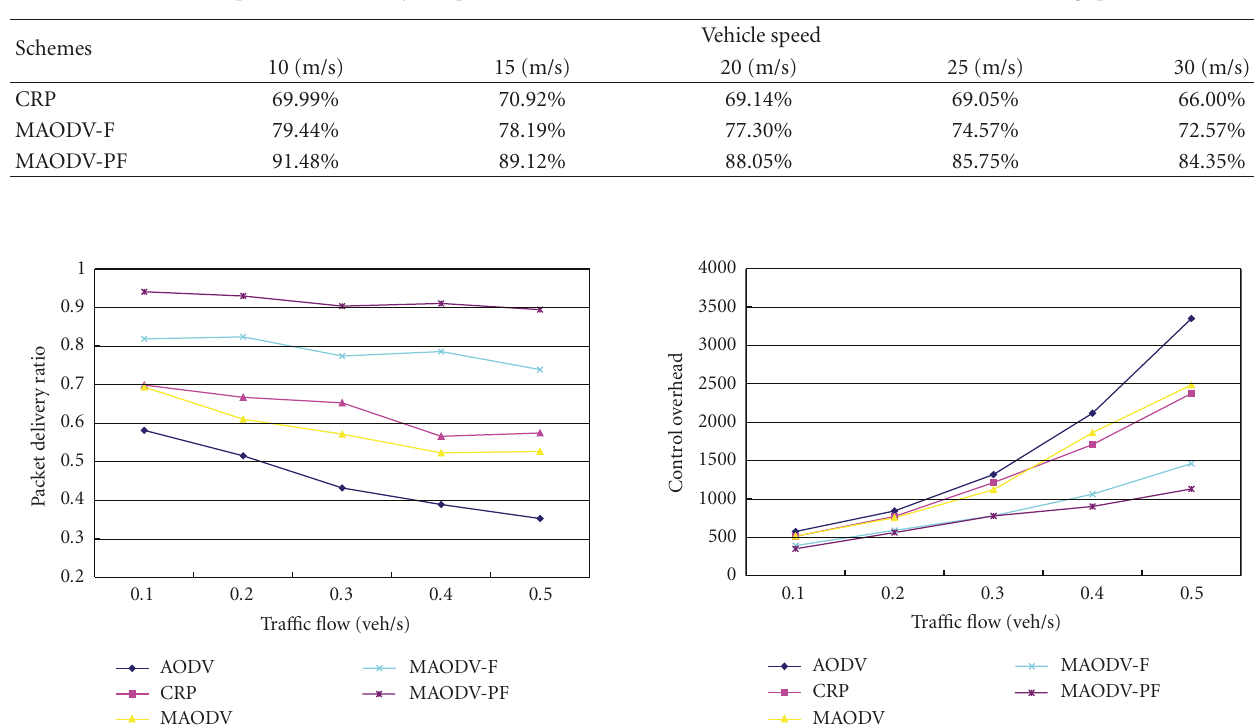
Table 2: The prediction accuracy comparison for CRP, MAODV-F, and MAODV-PF under di ff erent moving speeds.